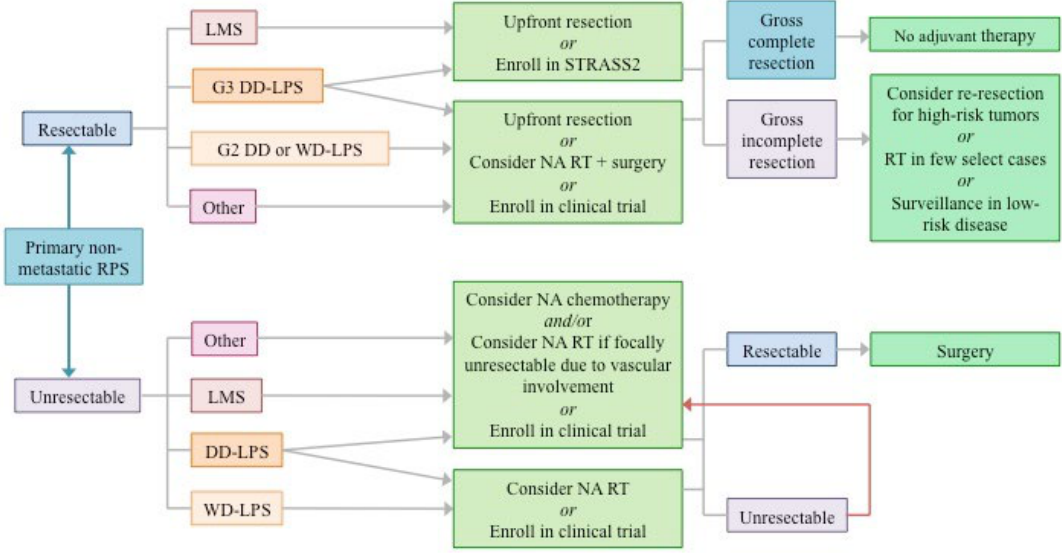
Figure 2. Approaches to neoadjuvant therapy for retroperitoneal sarcomas based on both general and histology-specific results from recent and ongoing studies; consistent with published guide- lines from ESMO-EURACAN, TARPSWG, and the NCCN.